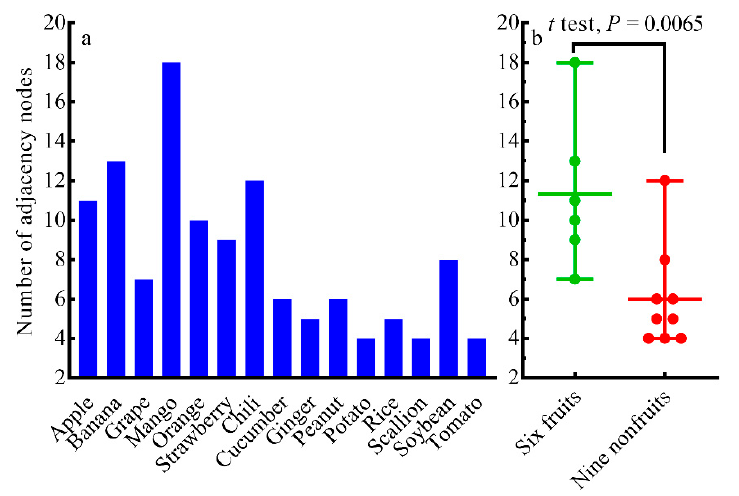
Figure 5. Numbers of adjacent nodes: ( a ) compared across all 15 crops; ( b ) compared between six fruits and nine nonfruits.